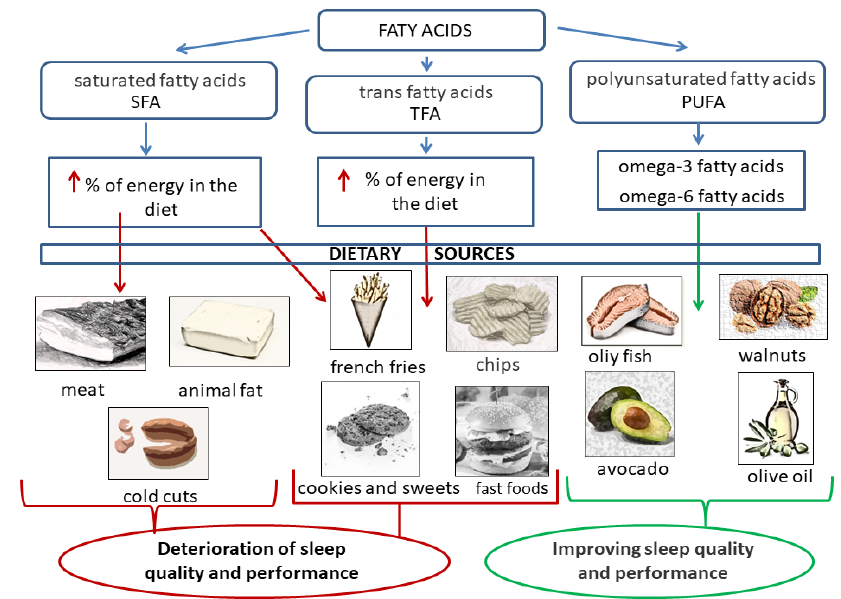
Figure 2. Dietary sources of fatty acids and their association with sleep quality.